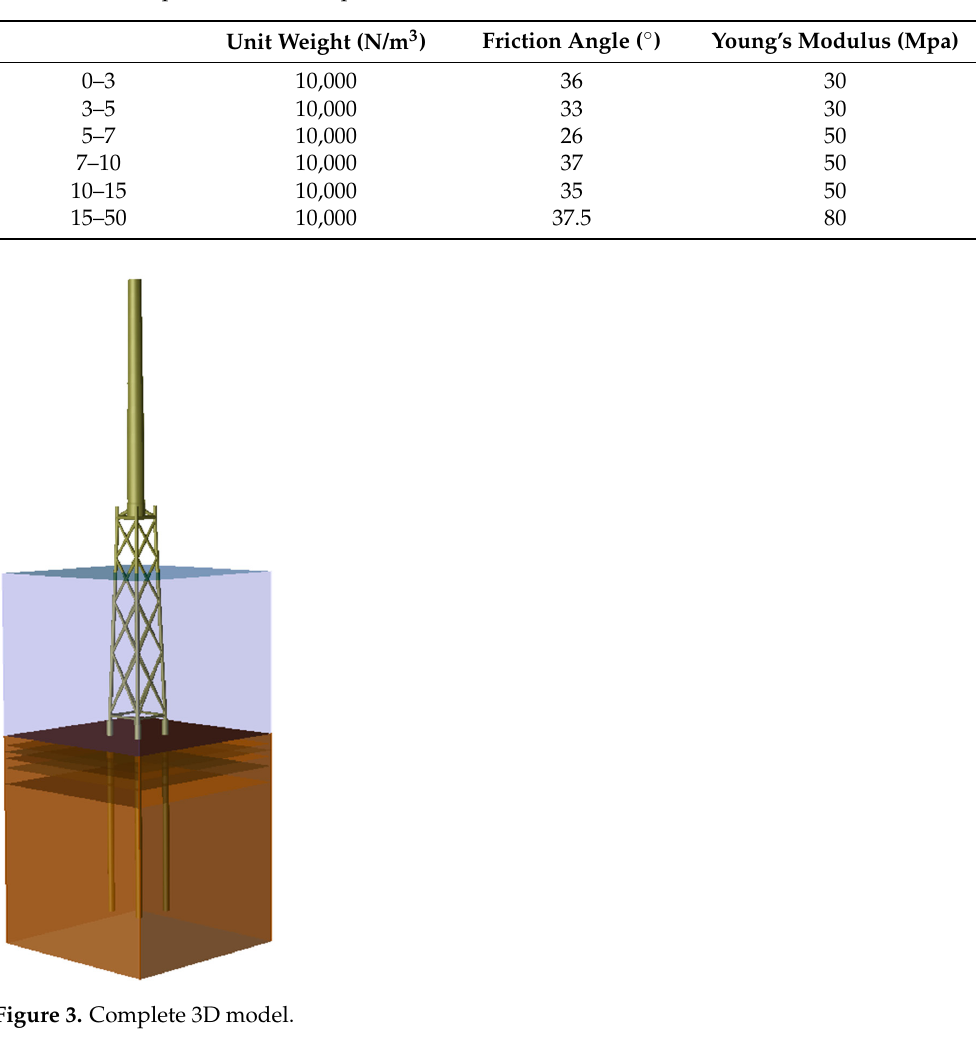
Table 4. The soil profile of k-13 deep-water site [26].